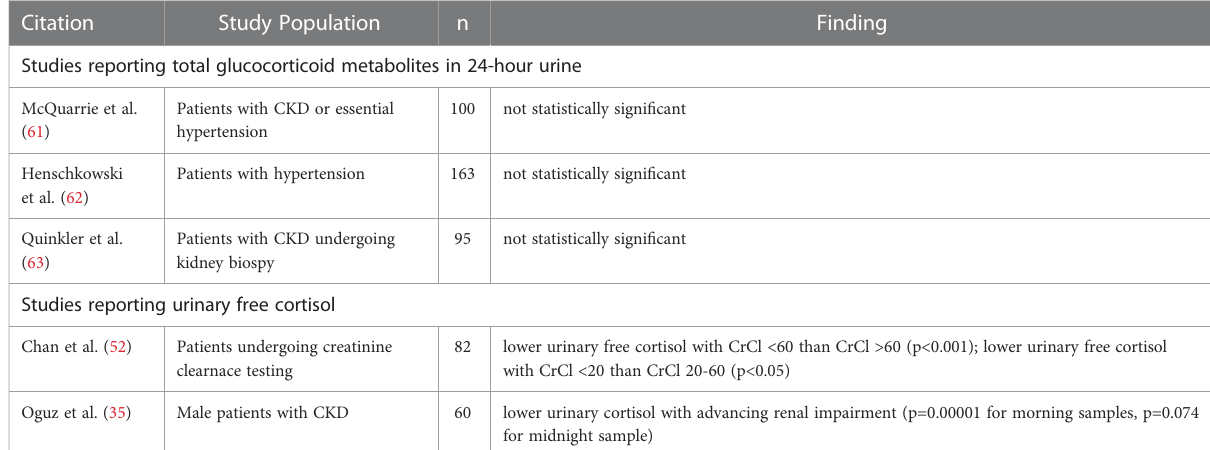
TABLE 3 Cortisol and cortisol metabolite measurements in